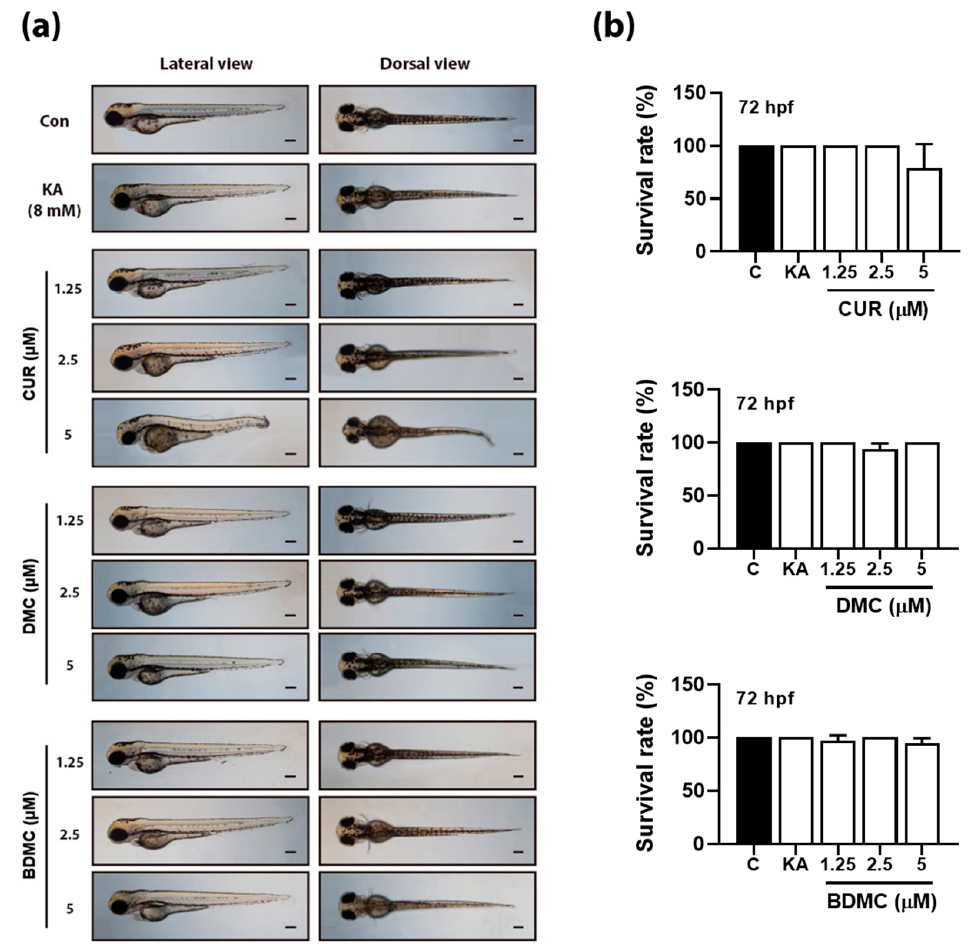
Figure 4. Acute toxicity of curcumin, dimethoxycurcumin and bisdemethoxycurcumin on early-stage development of zebrafish embryo. ( a ) Images of lateral and dorsal view of zebrafish embryo at 72 h after exposure to 8 mM of kojic acid (KA), various concentrations of curcumin (CUR), dimethoxycurcumin (DMC), and bisdemethoxycurcumin (BDMC). ( b ) Survival rate of zebrafish embryos after 72 h of treatment of 8 mM kojic acid or CUR, DMC, and BDMC. Hpf, hours post fertilization.